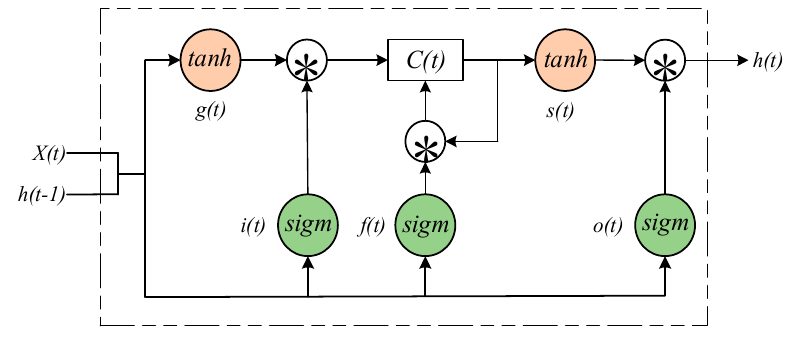
Figure 1. The Schematic diagram of an LSTM cell.